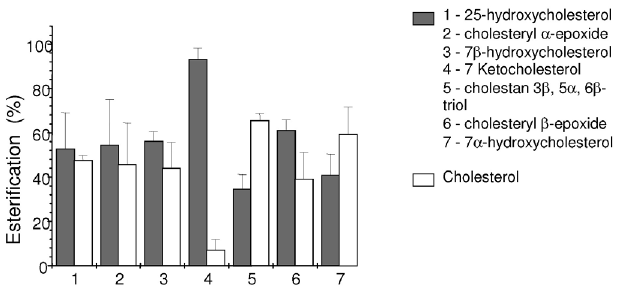
TABLE I - Incorporation of cholesterol oxides into HDL FIGURE 2 - Esterification (%) of cholesterol and cholesterol oxides both in the same HDL particle. The relative esterification incorporation into HDL (%) was calculated considering a sum of the esters formed from cholesterol and cholesterol oxides as 100% of